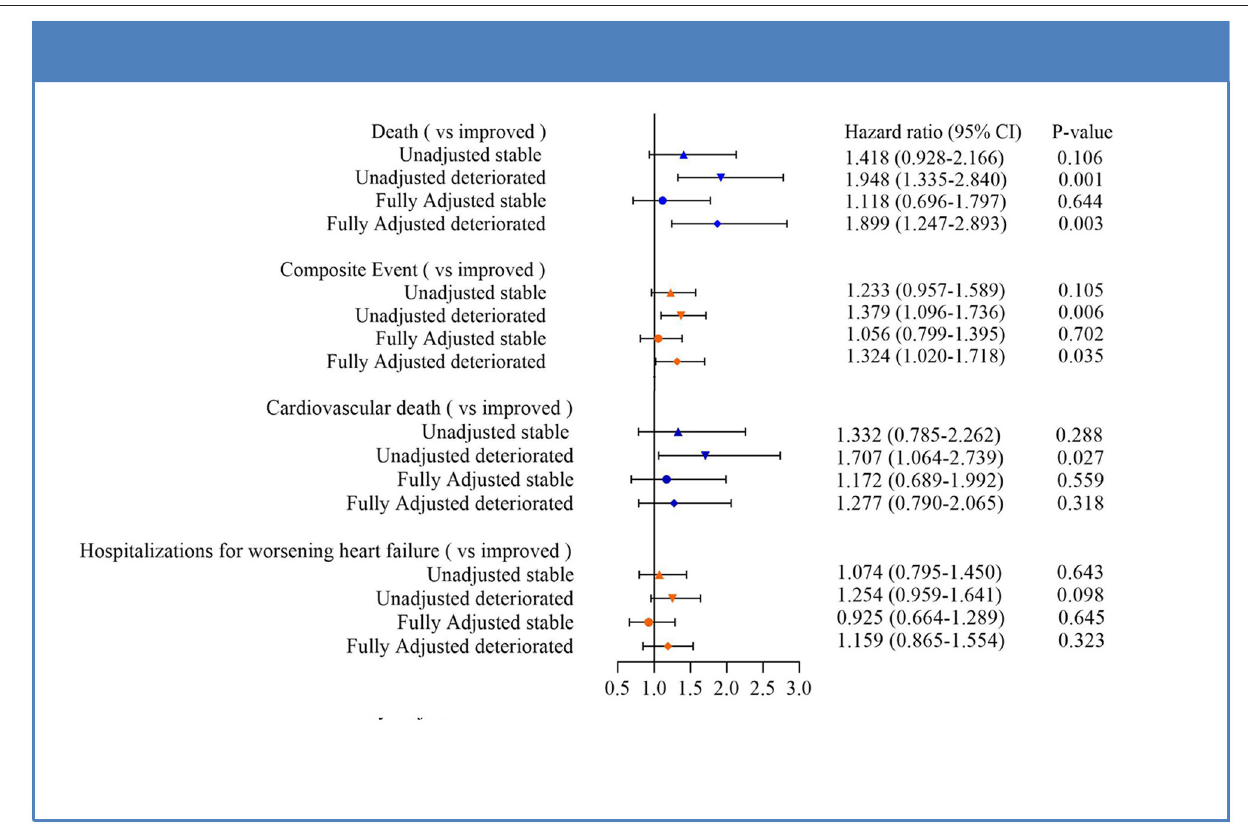
FIGURE 4 | Forest plot of clinical outcomes in HFmrEF